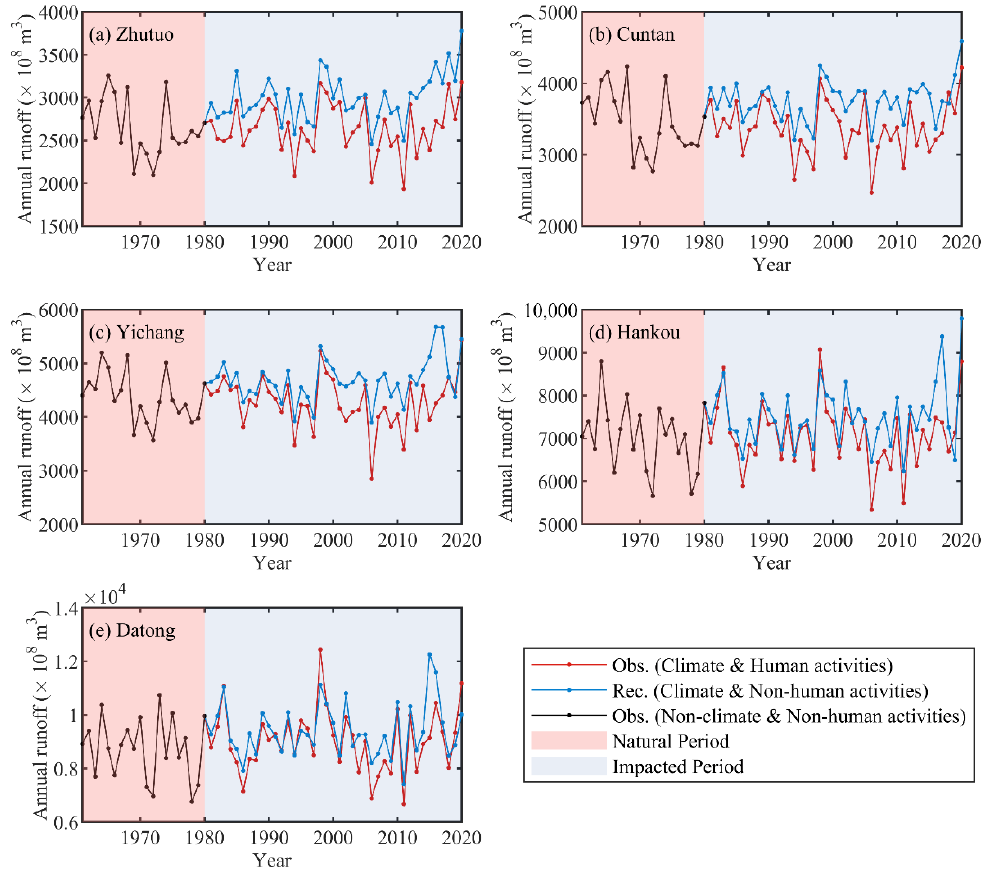
Figure 8. Variations of observed and reconstructed annual runoff at five hydrological stations.